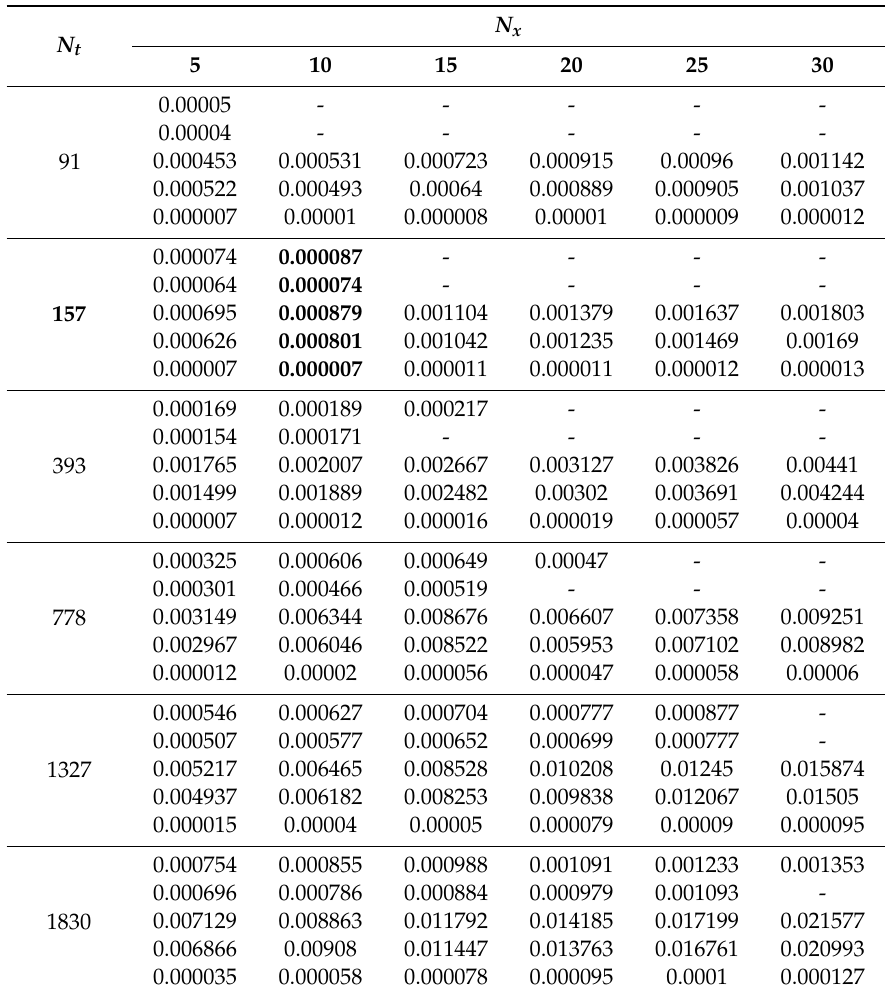
Table A2. Comparisons of the calculation time (seconds) for used di ff erence schemes and the generation